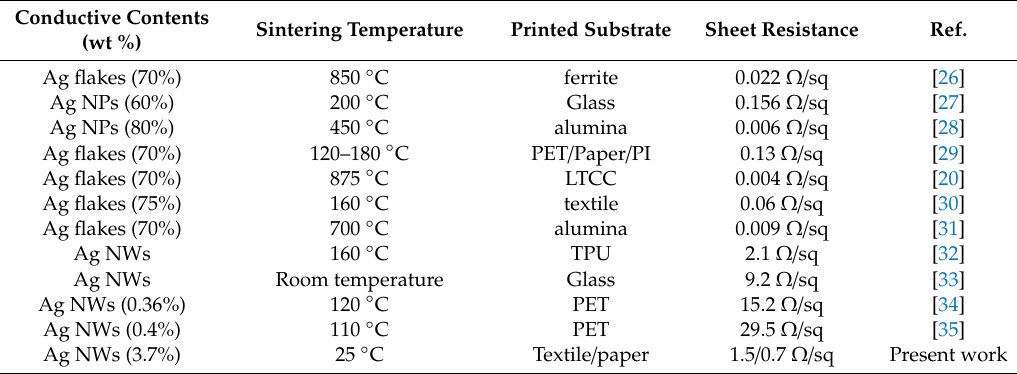
Table 1. The conductive performance in di ff erent screen printing